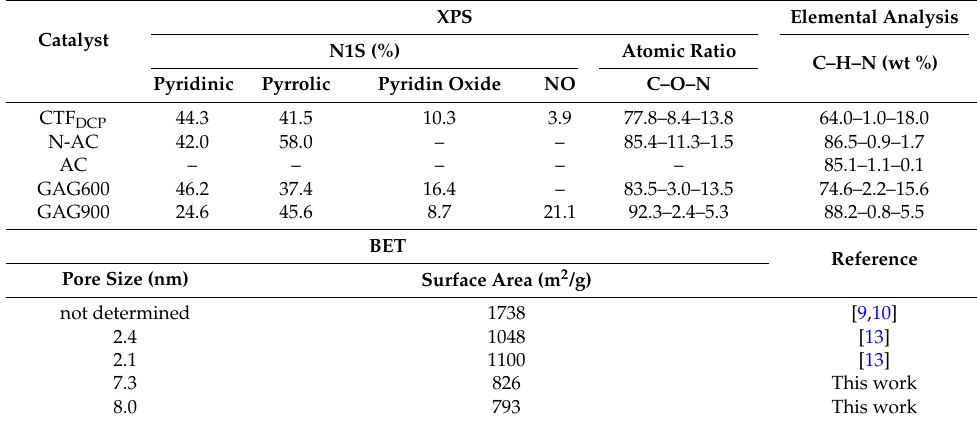
Table 3. Characteristics of N ‐ containing supports.